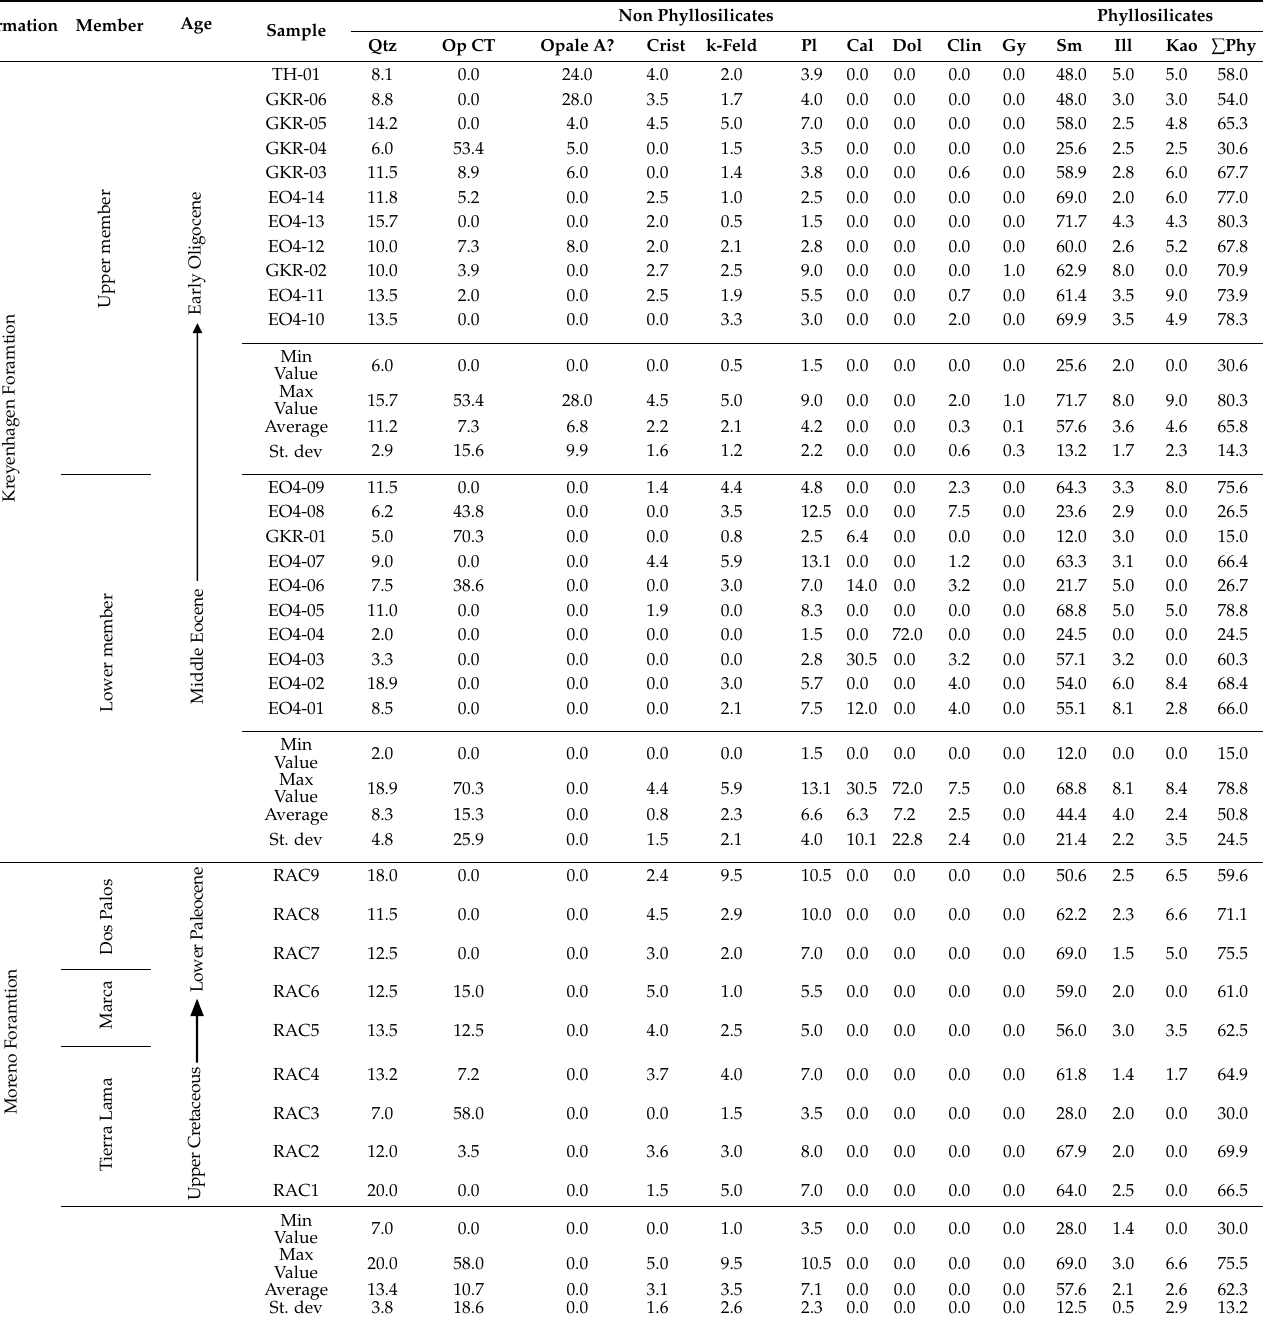
Table 1. Whole-rock mineralogy (wt %) for Kreyenhagen and Moreno formations estimated from X-ray diffraction (XRD) analysis. Qtz = quartz; Op CT = opal CT; Opal A? = amorphous material and probably opal A; Crist = cristobalite; K-feld = K-feldspar; Pl = plagioclase; Cal = calcite; Dol = dolomite; Clin = clinoptilolite; Gy = gypsum; Sm = smectite; Ill = illite; Kao = kaolinite; Σ Phy = total phyllosilicates. Table 2 . Major element chemistry for samples shown in Table 1. LOI = loss on ignition. CIA = chemical index of alteration Formation Member